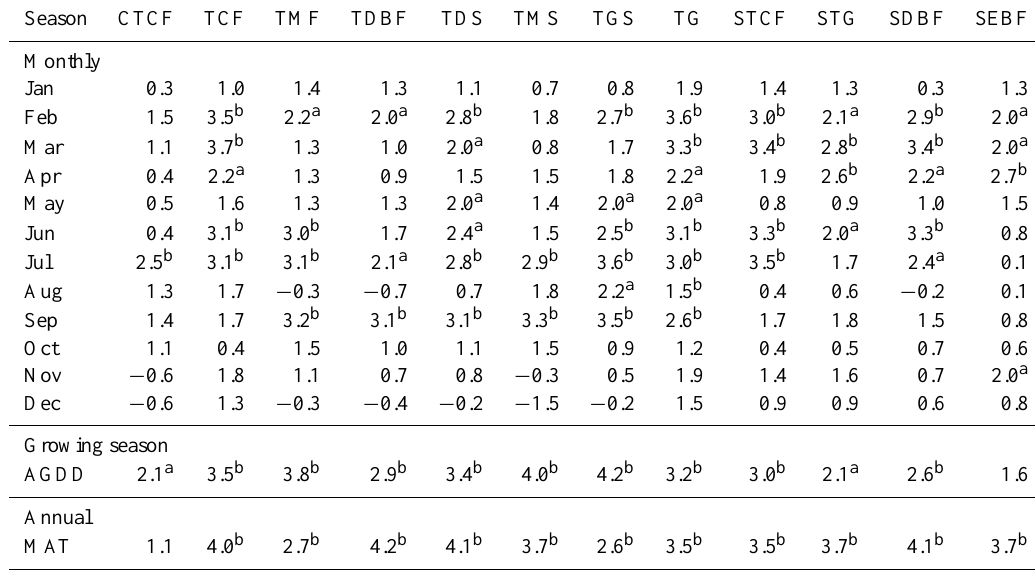
Table 2. Seasonal Mann–Kendall (SMK) trend tests of temperature by vegetation types from 1982 to 2006.